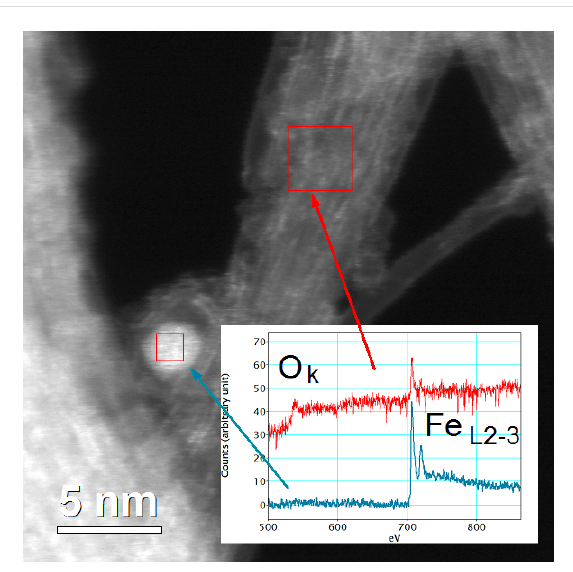
Figure 9: An example of a STEM HAADF image of the HIPCO-HNO 3 - FcETG 2 sample. Inset: EELS spectra of the catalyst particle (blue arrow) and of the bundle recorded in the area of the red square.